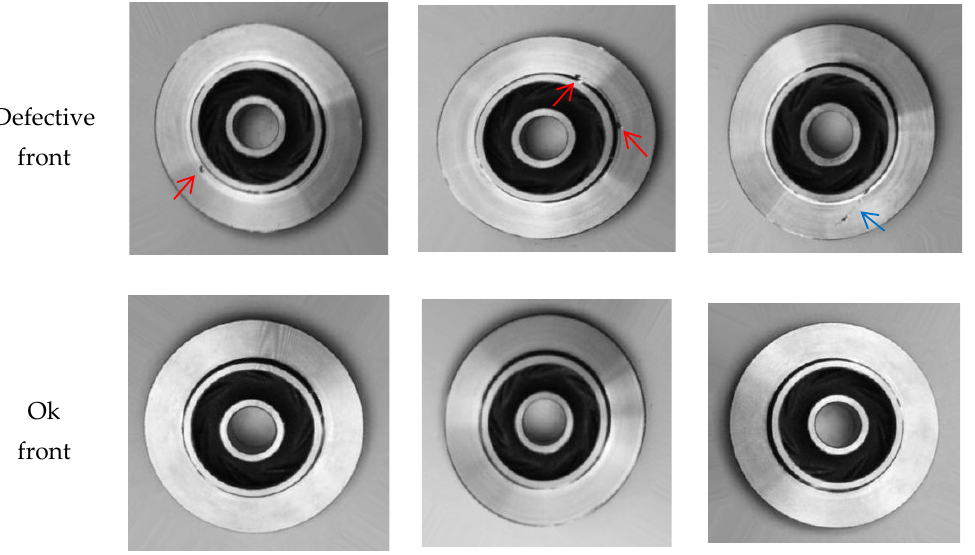
Figure 1. Def-front and ok-front samples from the dataset. Pinholes are marked with red arrows; scratches are marked with a blue arrow.